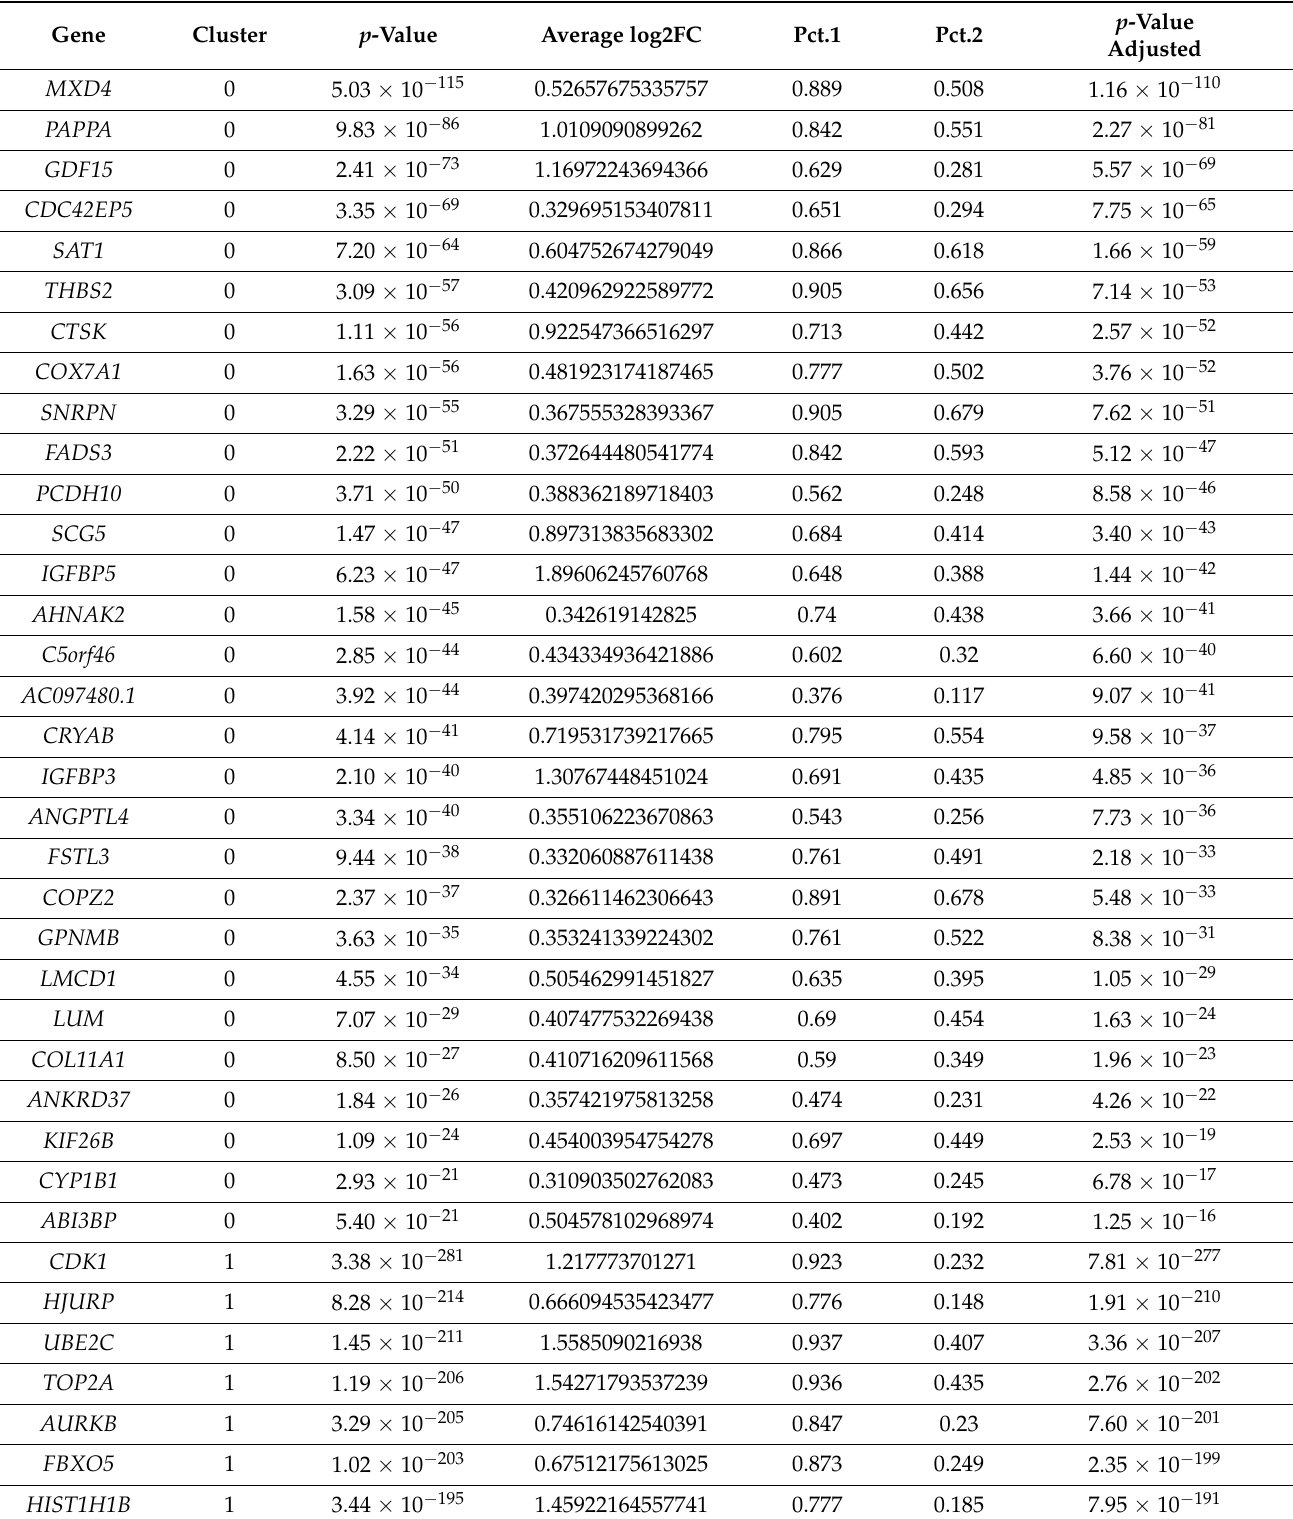
Table 2. Highly variable genes after cell cycle regression in CAFs isolated from